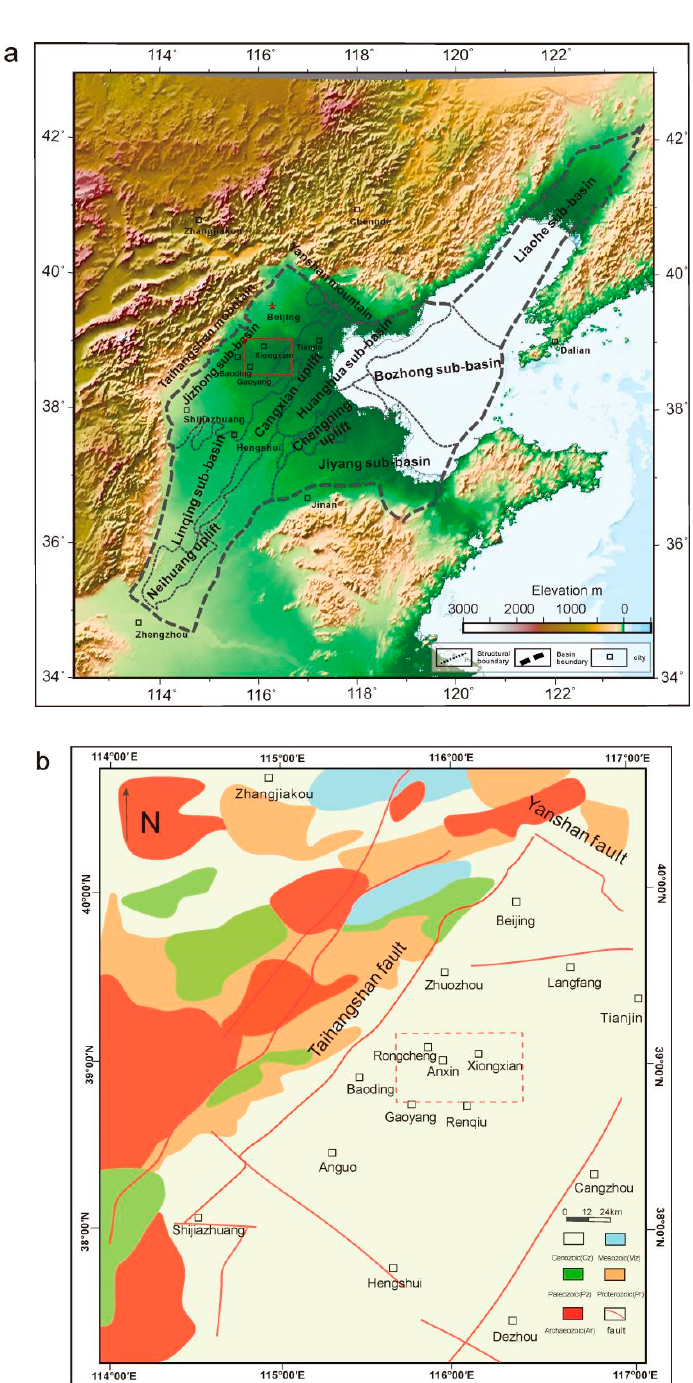
Figure 1. Structural unit divisions and stratigraphy distribution characteristics of the Xiong’an New Area (subfigure a adapted from Qiu [20]). Geotectonic location and regional geological map of the Xiong’an New Area ( a ); Stratigraphy and geological distribution characteristics of the Xiong’an New Area ( b ).